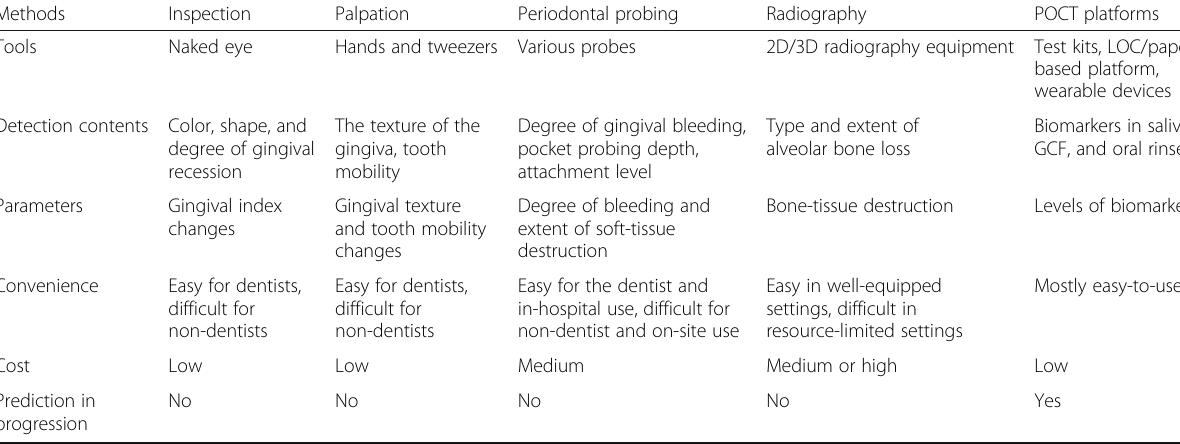
Table 2 Comparisons of clinical methods and POCT platforms for periodontitis diagnosis [7]